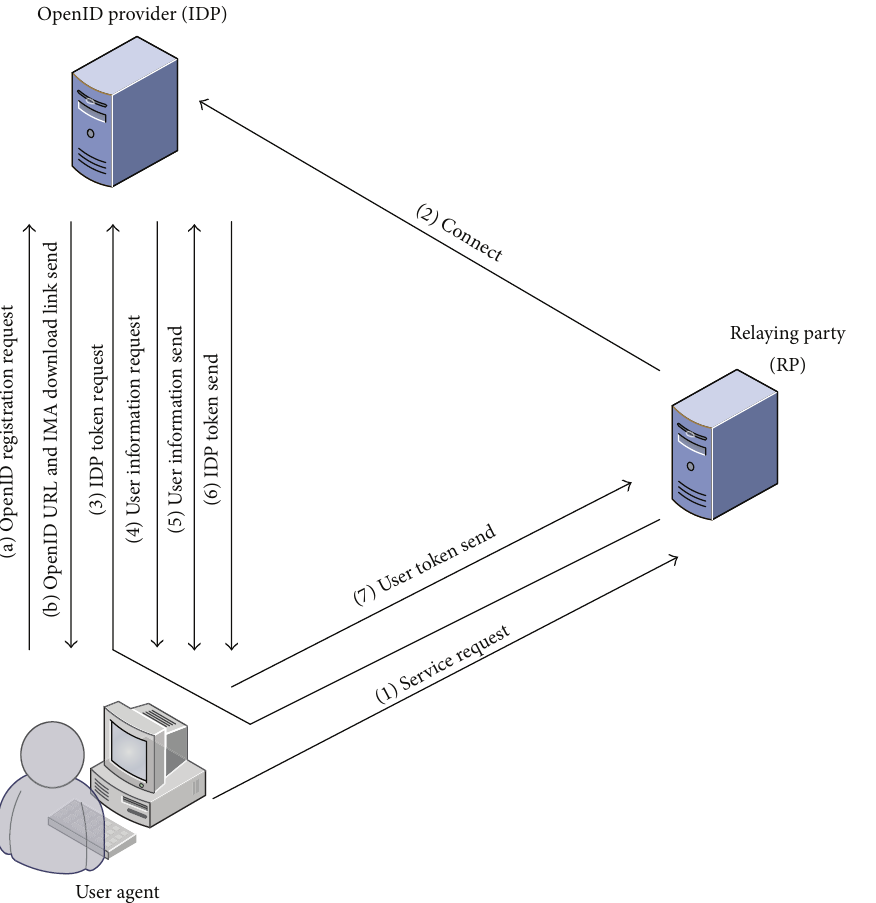
Figure 3: The proposed